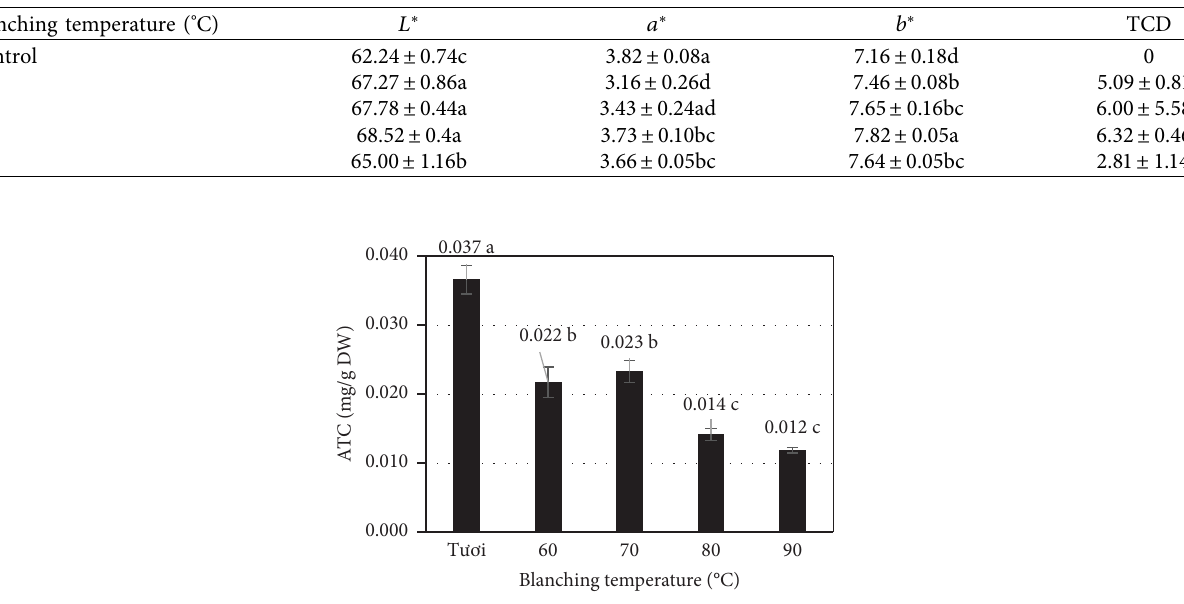
Table 2: Efect of blanching temperature on color.